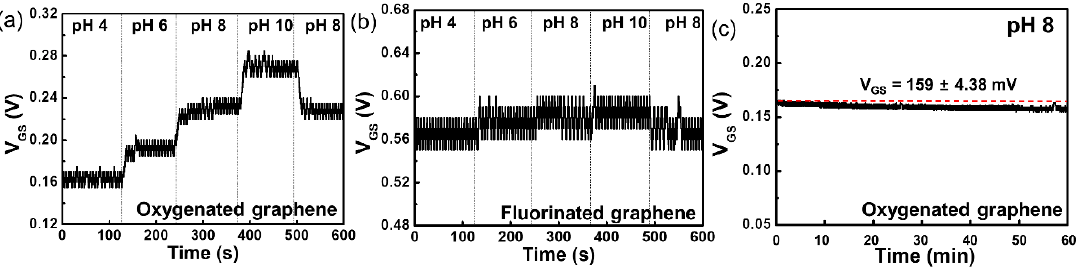
Figure 4. Real-time detection of pH in electrolyte solution using ( a ) oxygenated G-ISFET and ( b ) Figure 4. Real-timedetectionofpHinelectrolytesolutionusing( a )oxygenatedG-ISFETand( b )fluorinated fluorinated G-ISFET. ( c ) Long-term stability of oxygenated G-ISFET in a buffer solution of pH 8. G-ISFET. ( c ) Long-term stability of oxygenated G-ISFET in a bu ff er solution of pH